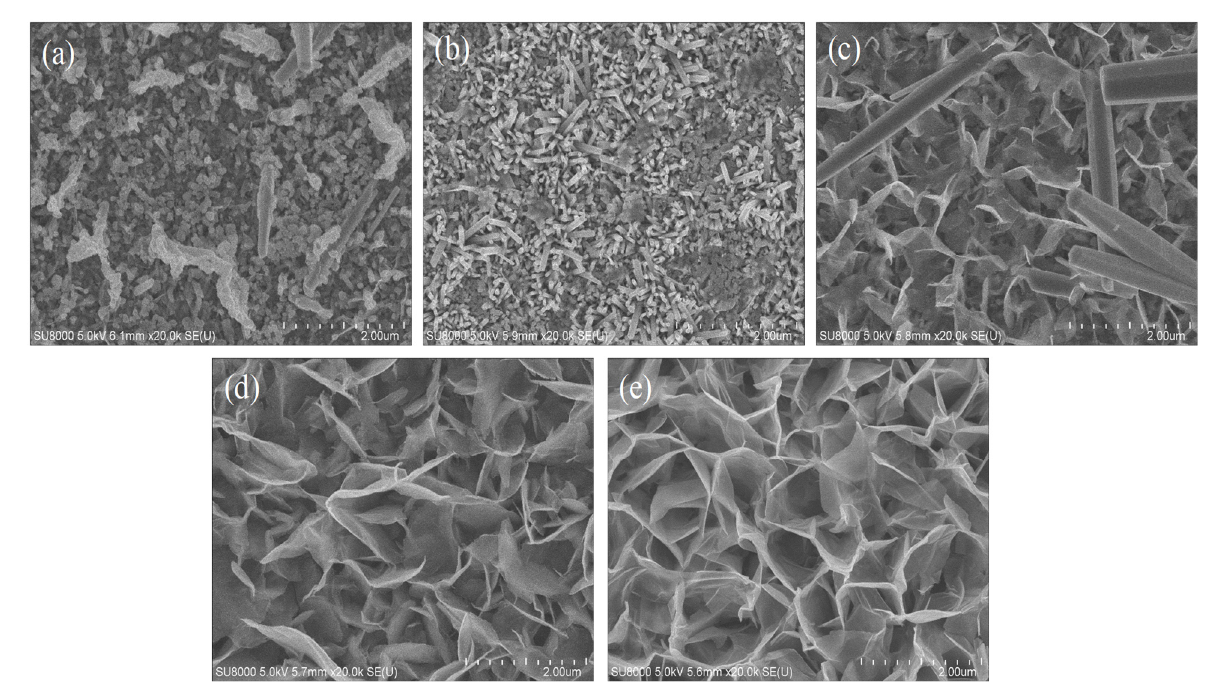
Figure 4. SEM images of ( a ) pure AZO, ( b ) AZO with 10 nm of Al, ( c ) AZO with 20 nm of Al, ( d ) AZO with 40 nm of Al, ( e ) AZO with 80 nm of Al.